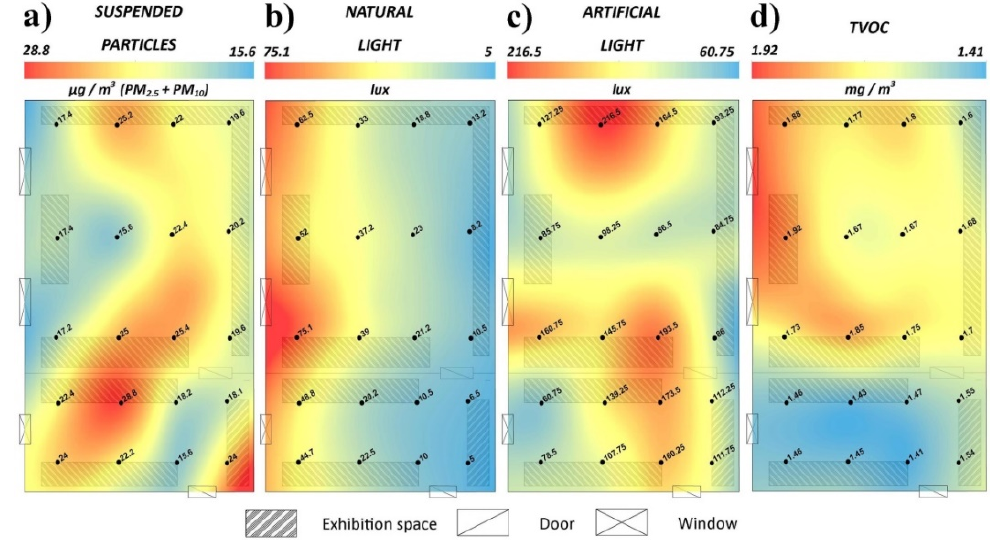
Figure 8. Distribution in space of average values for suspended particles, brightness, and TVOC ( a – d ) throughout the entire period of measurements performed inside the exhibition halls located in the basement.